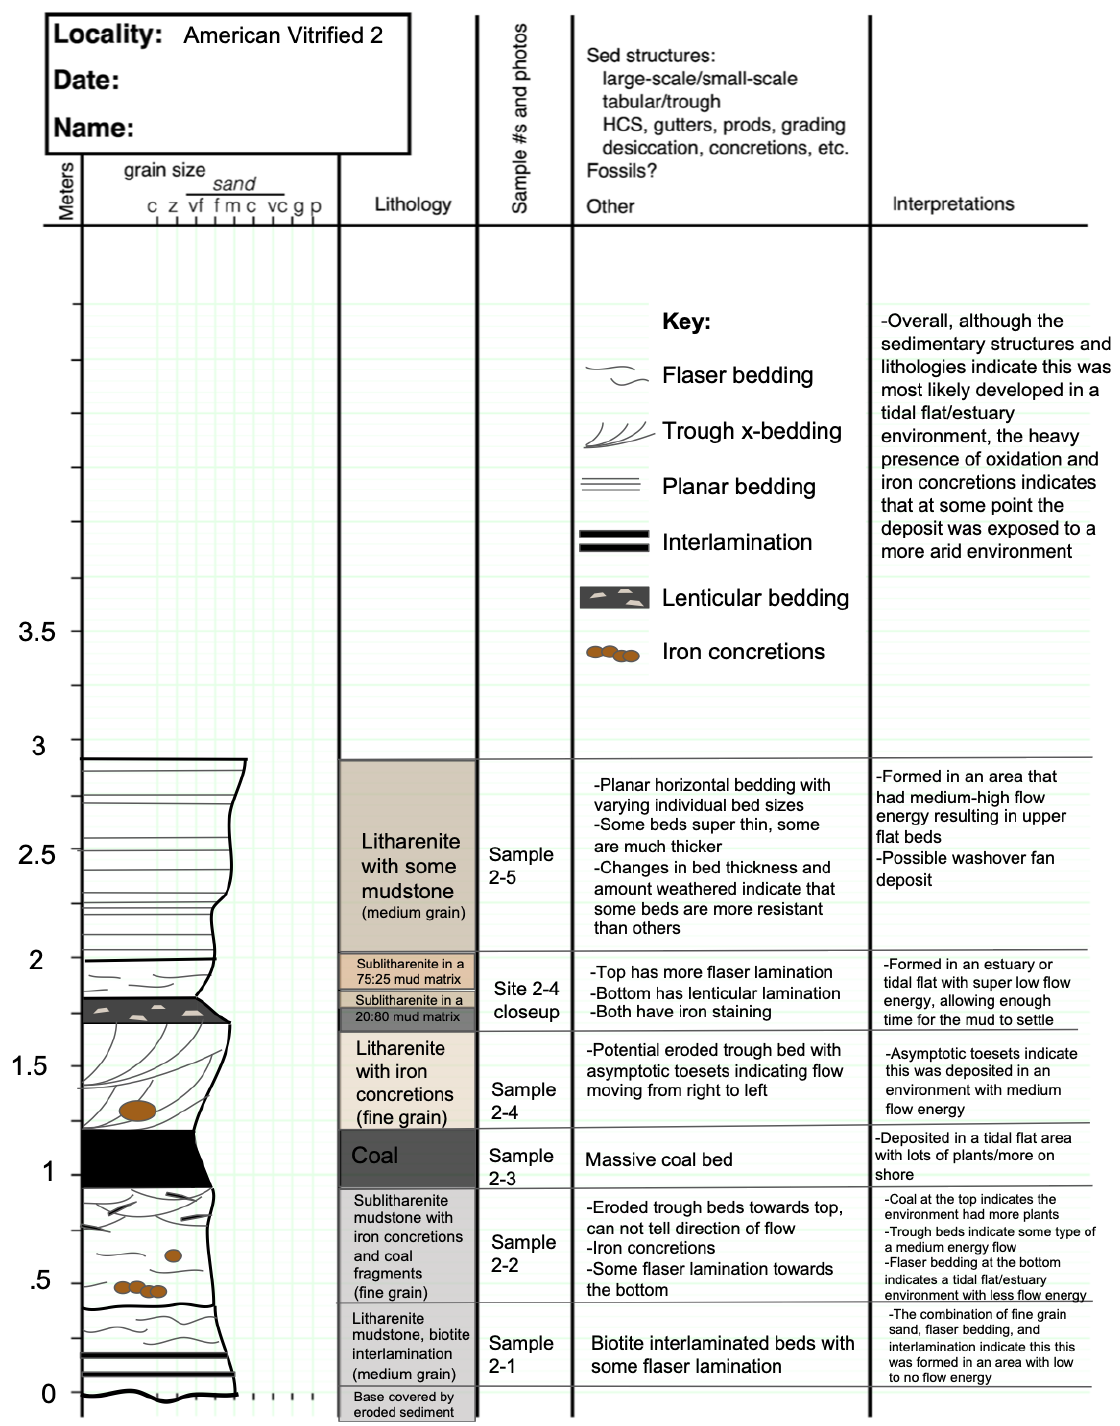
Figure 6. Example student stratigraphic section drafted from American Vitrified 2 outcrop data. This is a product from Part 5 of the assignment, using data collected in Parts 1–4 of the assignment (examples of data shown in Figs. 1–5). Stratigraphic columns that students produce include the graphic log, descriptions, and